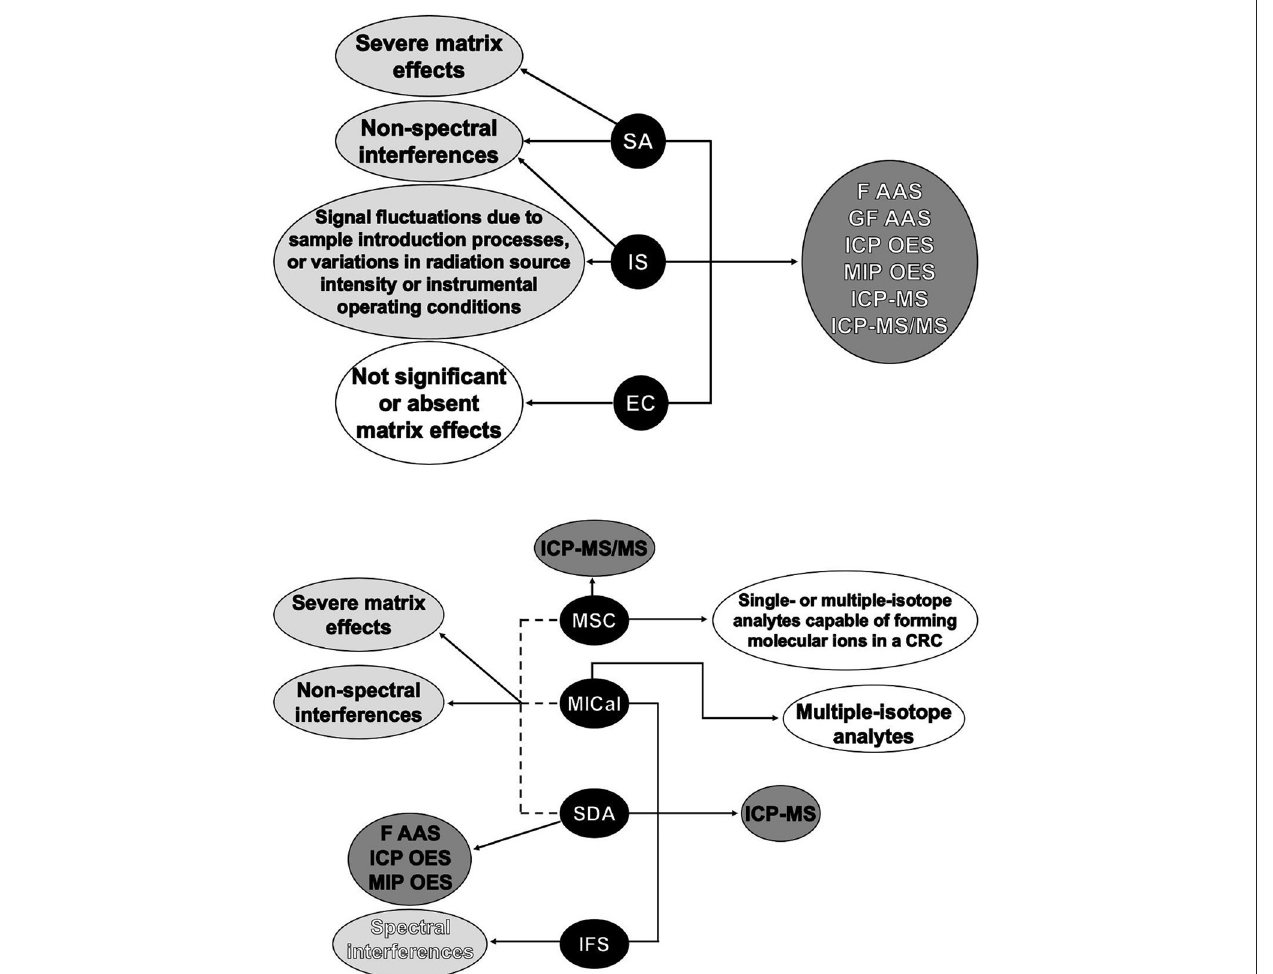
FIGURE 8 | Summary of the most adequate general applications for EC, IS, SA, IFS, SDA, MICal, and MSC.